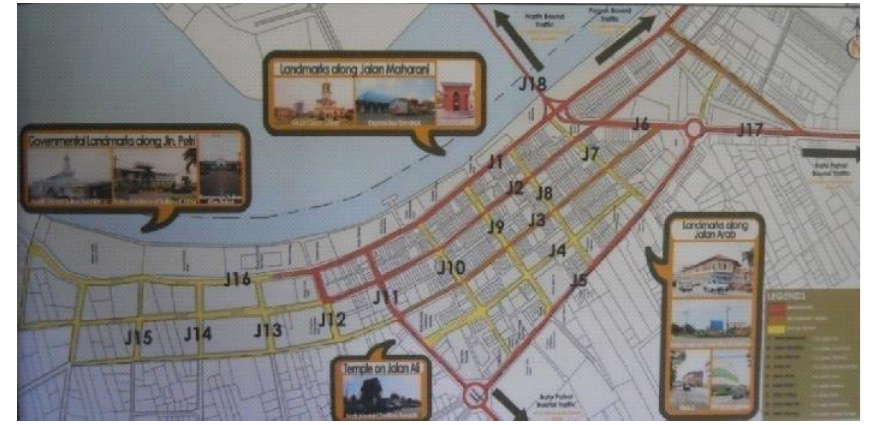
Fig. 3: Overall map indicating the roads, place-markers, and ingress/egress of the Muar